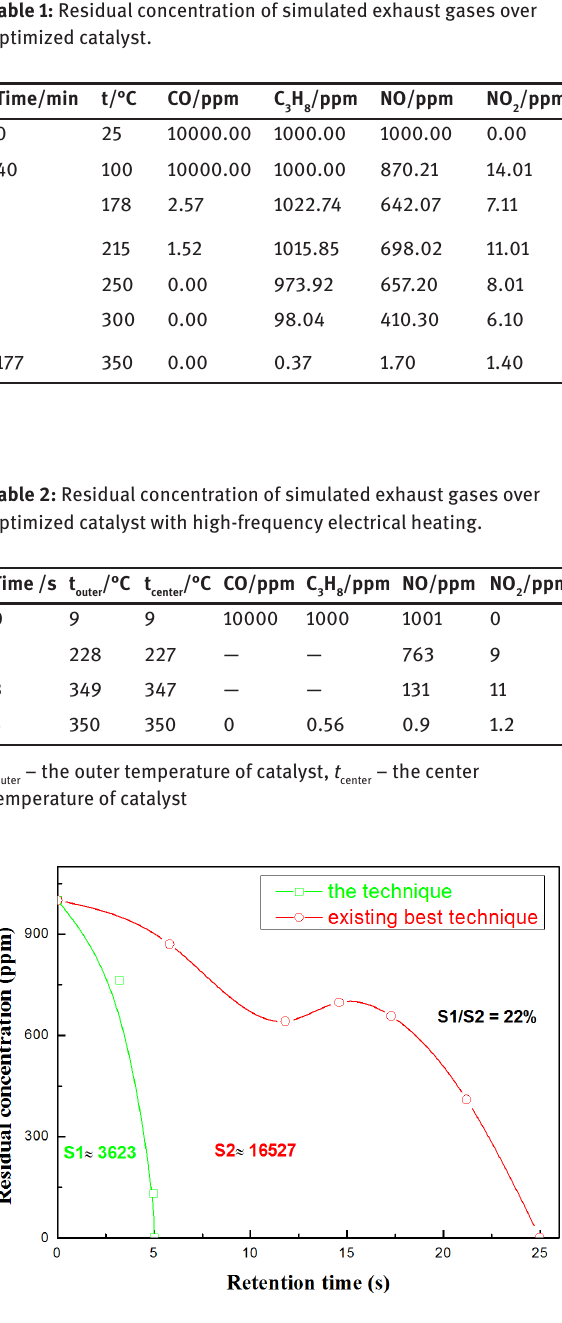
Figure 3: Comparison of NO removal effect between traditional and novel catalyst at engine cold-start